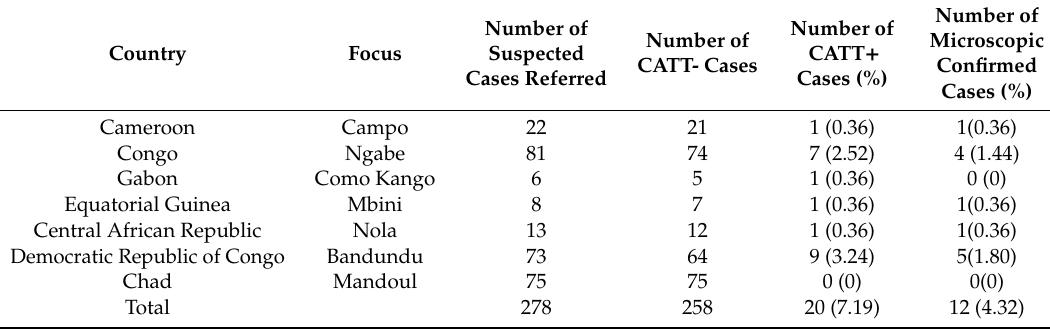
Table 2. Diagnosis Test Results of HAT Suspects.